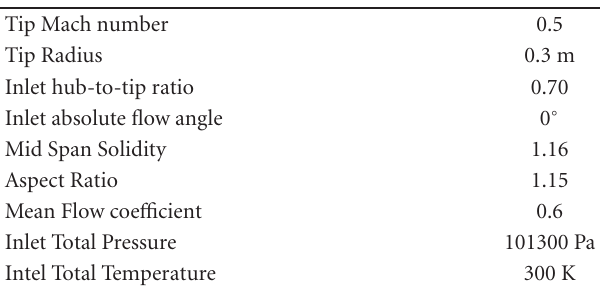
Table 1: Design parameters of the blades.